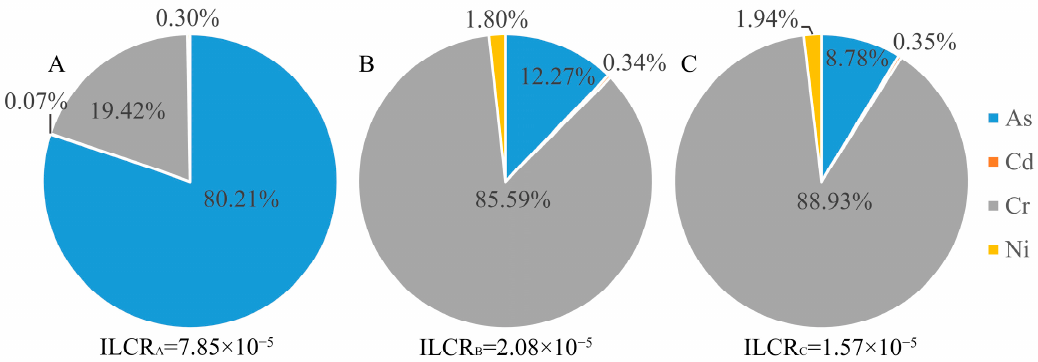
Figure 7. Carcinogenic risk contribution rate for skin contact with heavy metals in soil. A, B and C represent area A, area B and area C, respectively.